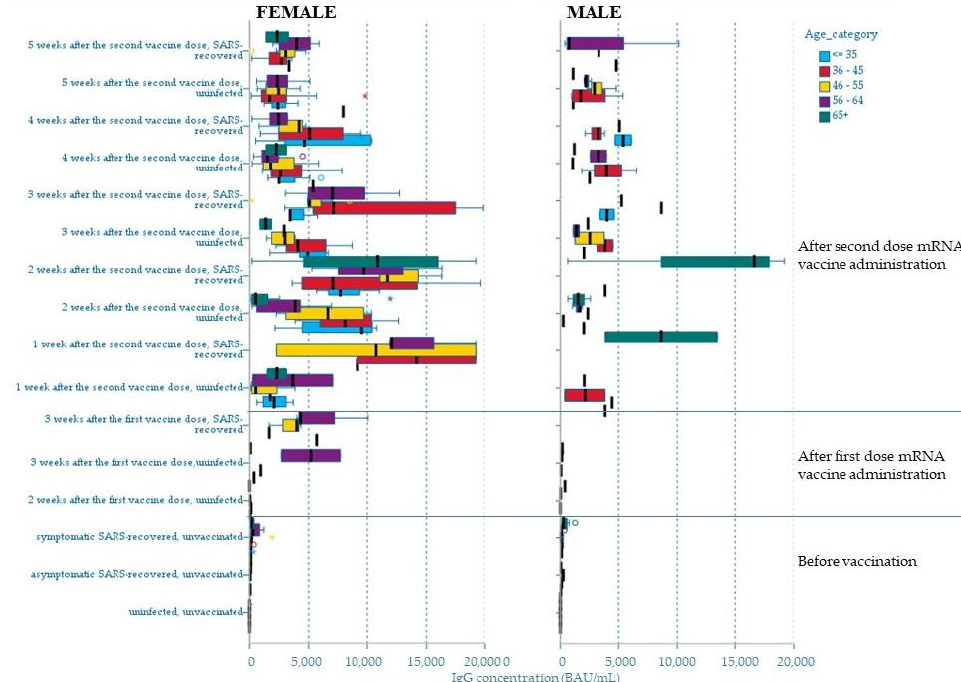
Figure 2. Distribution of the mean values of anti-SARS-CoV-2 IgG antibodies in relation to age and the distribution of anti-SARS-CoV-2 IgG concentrations by sex of the study participants.